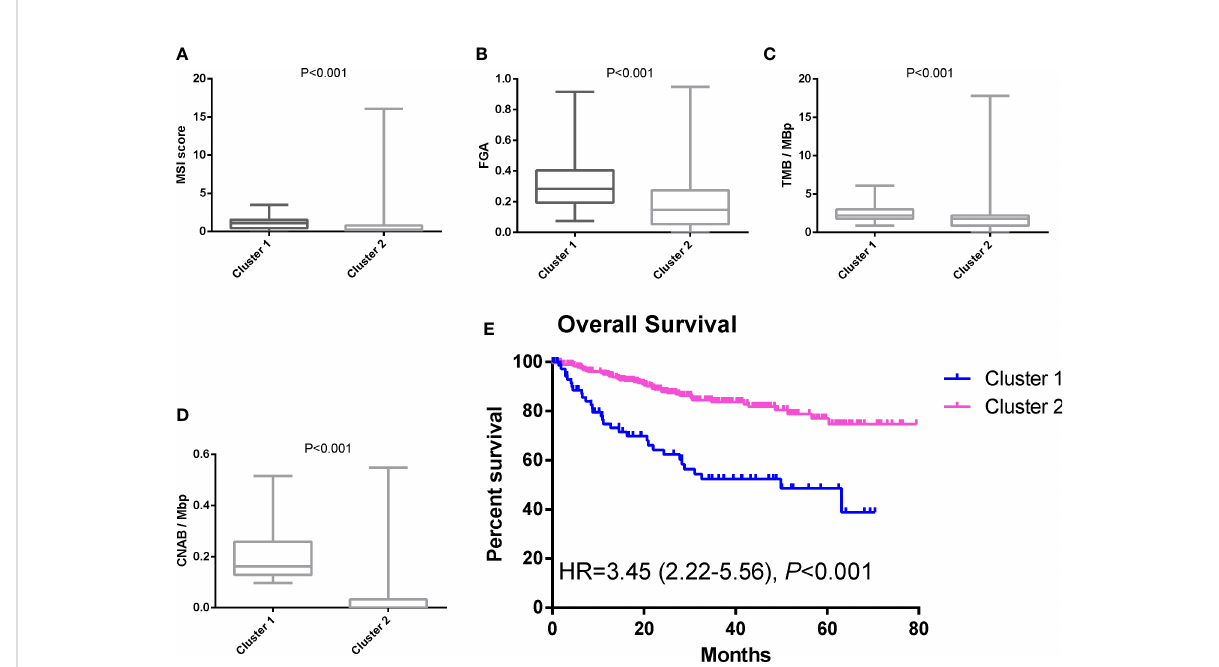
FIGURE 2 Differences in MSI score, FGA score, TMB, CNAB, and prognosis between different clusters. (A) MSI; (B) FGA; (C) TMB; (D) CNAB; (E) Kaplan- Meier curves. MSI, microsatellite instability; FGA, fraction genome altered; TMB, tumor mutational burden; CNAB, copy number alteration burden; HR, hazard ratio.